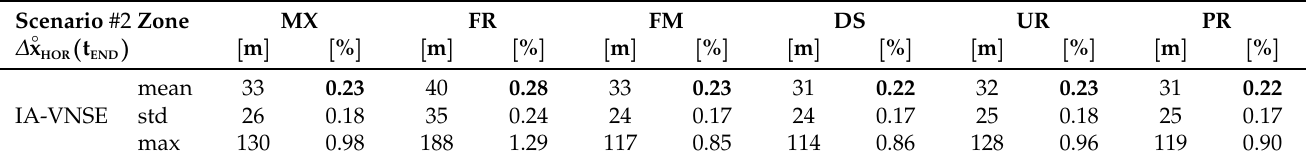
Table 8. Influence of terrain type on final horizontal position IA-VNSE for scenario #2 (100 runs). The most important metrics appear in